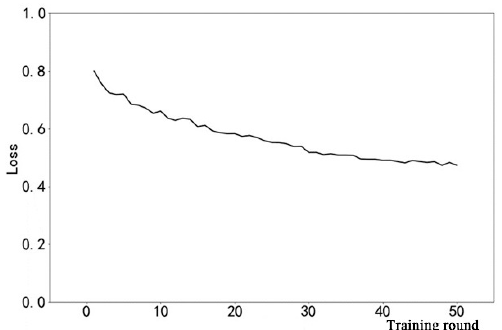
Figure 9. Loss curve of the first 50 training rounds.